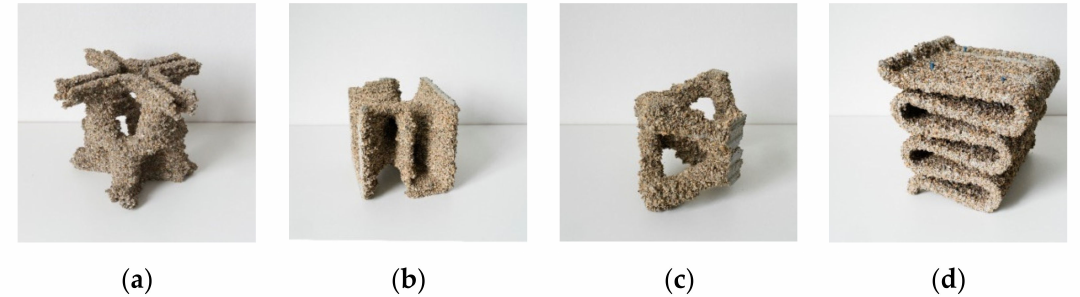
Figure 14. Design studies in scale 1:5 (25 × 25 × 25 cm 3 ) conducted within the course “Digital Building Fabrication Studio” (DBFS) in winter semester 2020/2021 at Technische Universität Braunschweig, ( a – d ) various designs suggested for LP3DCP with ( b ) being the chosen